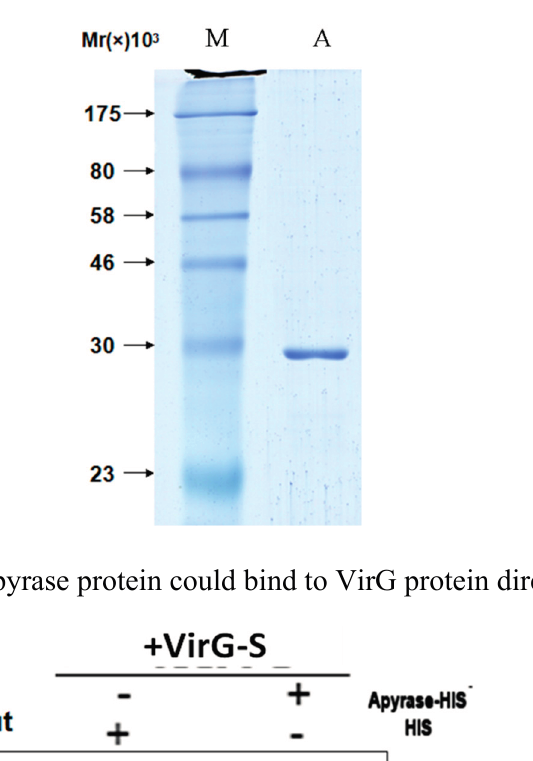
Figure 3. The purified protein apyrase was identified by SDS-PAGE. Line M: molecular